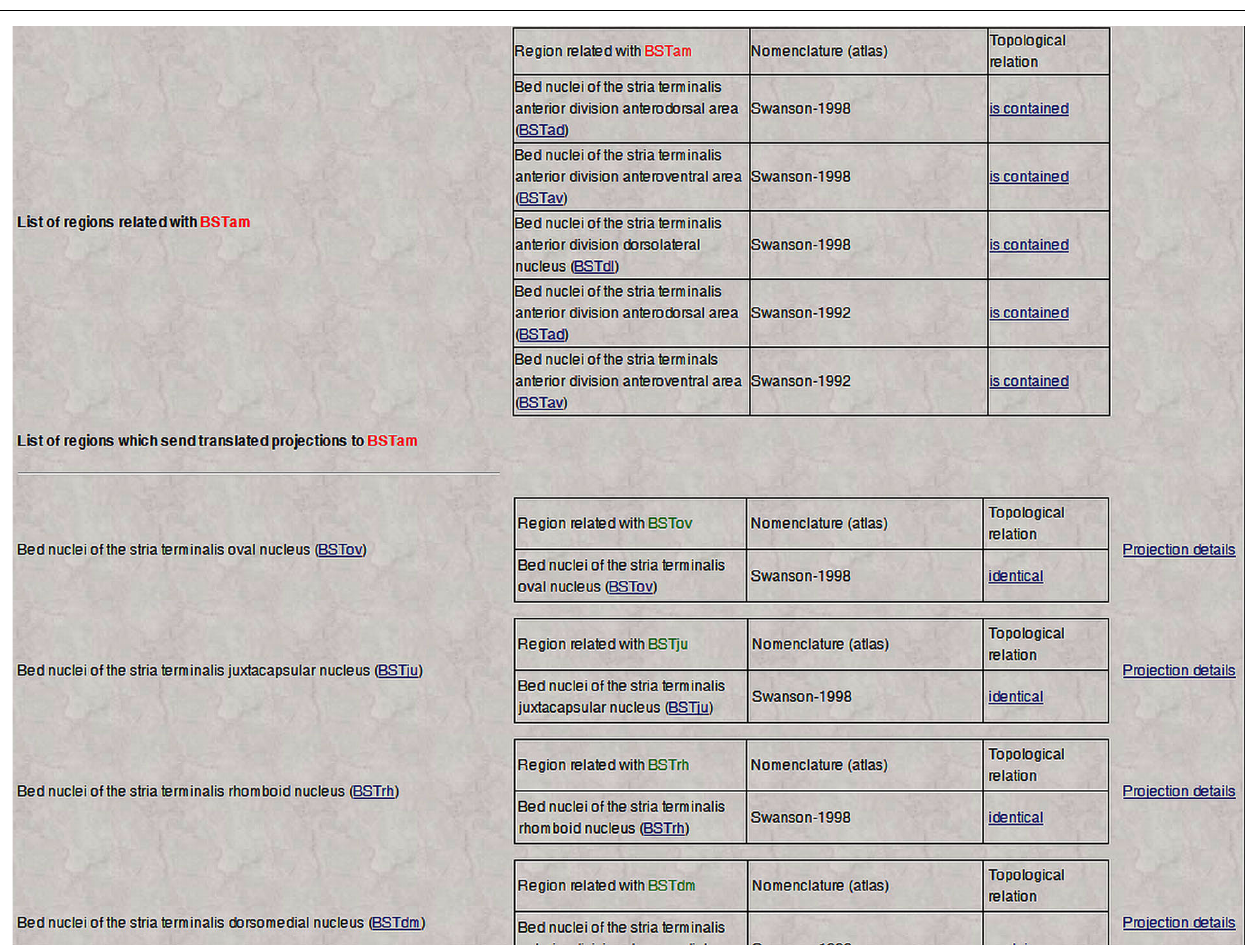
one of interest (Swanson, 2004), links to details of the translated projections, and of the topological relations between original and translated regions.